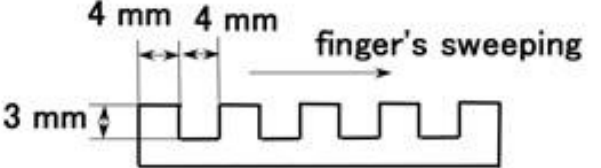
Figure 20. Schematic diagram of the concave and convex body in stroking experiment.